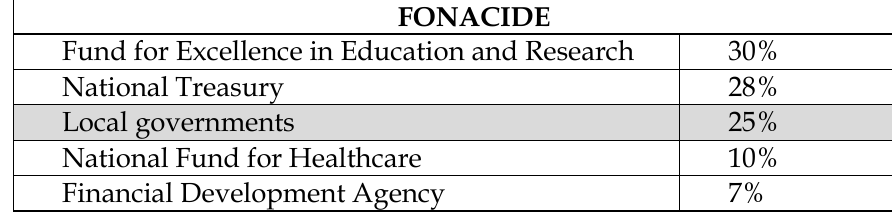
Table 3. Allocation for the FONACIDE Resources According to Sector FONACIDE Fund for Excellence in Education and Research 30% National Treasury 28% Local governments 25% National Fund for Healthcare 10% Financial Development Agency 7% Source: Law